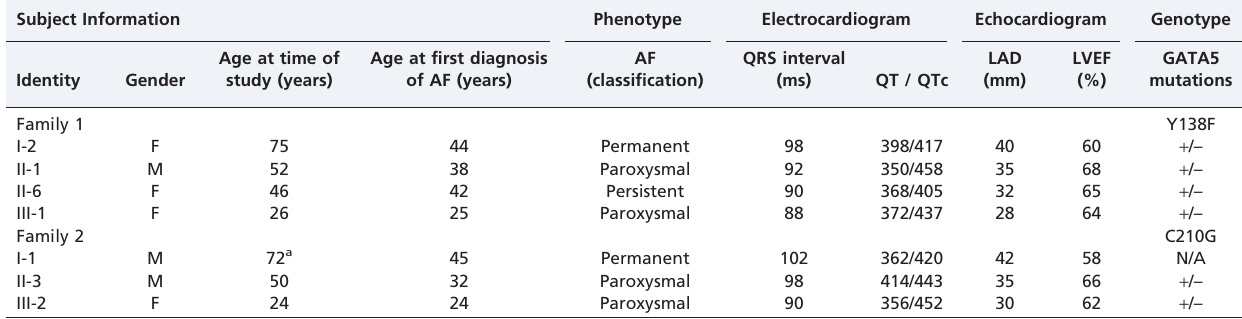
Table 2 - Phenotypic characteristics and the GATA5 mutation status of the affected pedigree members.